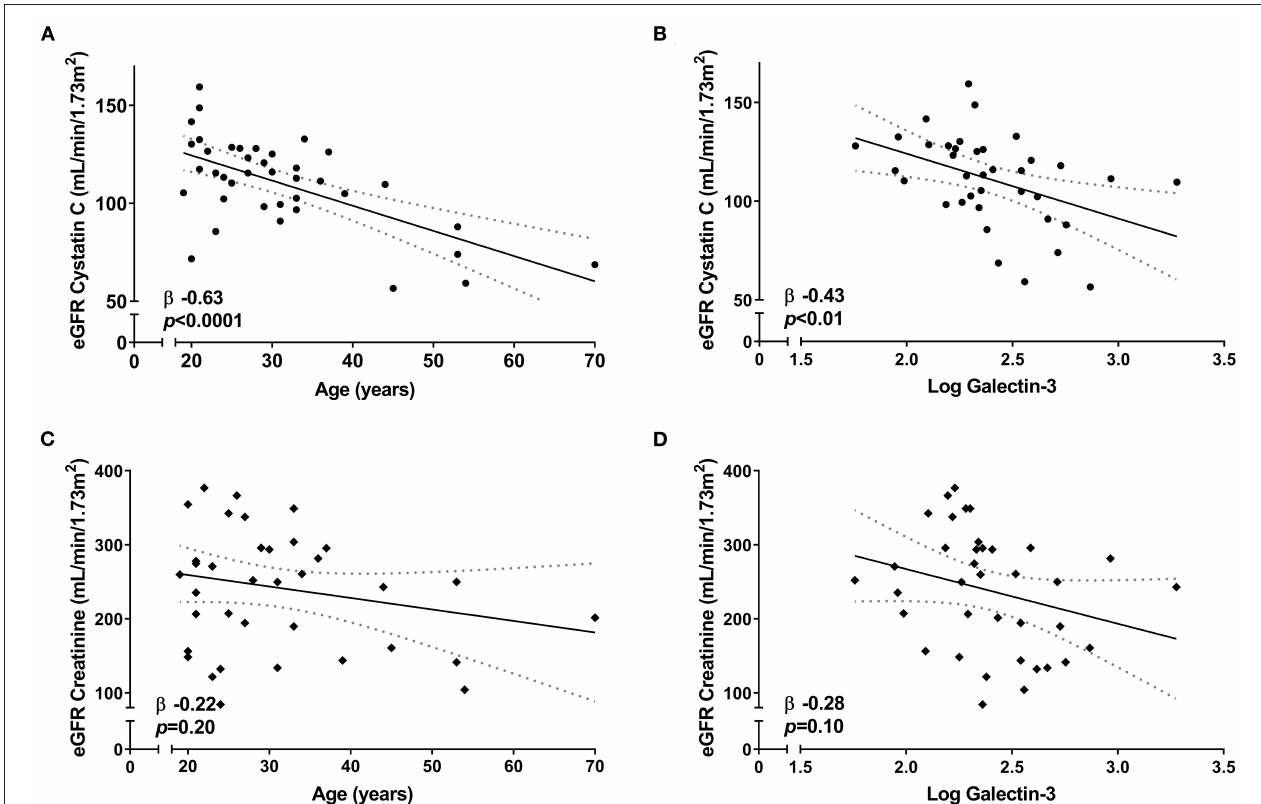
FIGURE 1 | Correlation between eGFR and renal parameters among the 39 neuromuscular dystrophy patients in this study. Linear regression [95% CI] showing the correlation of Cystatin C-based eGFR with (A) age and (B) galectin-3 levels. Linear regression [95% CI] showing the correlation of creatinine-based eGFR with (C) age and (D) galectin-3